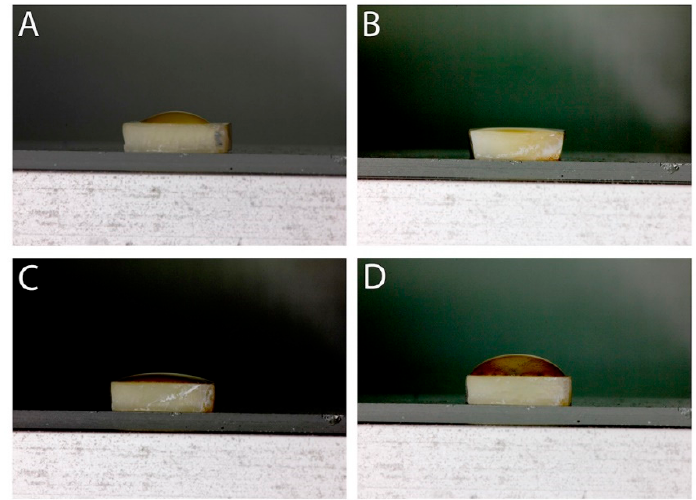
Figure 3. Representative images of contact angle of different adhesives; The adhesive drop is shown